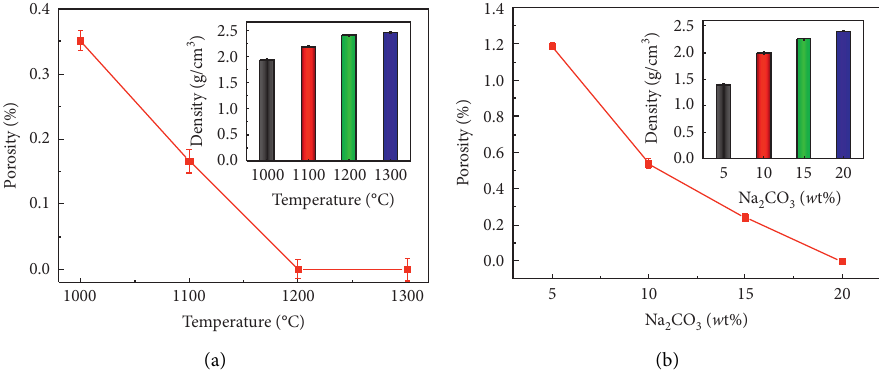
Figure 6: The influence of sintering temperature (a) and the effect of Na